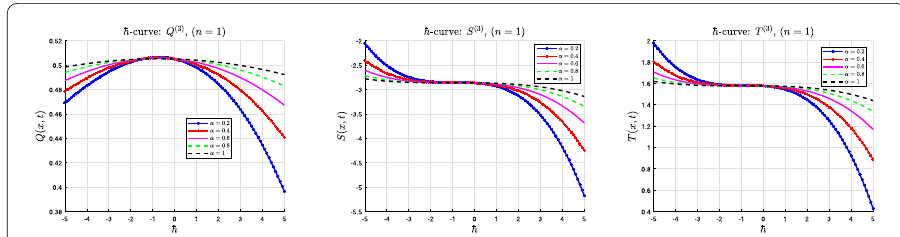
Figure 18 (cid:2) -curves plot with different α when k = η = 0.1, r = –1.5, p = 1.5, x = 10, and t = 0.1 for Example 4.1